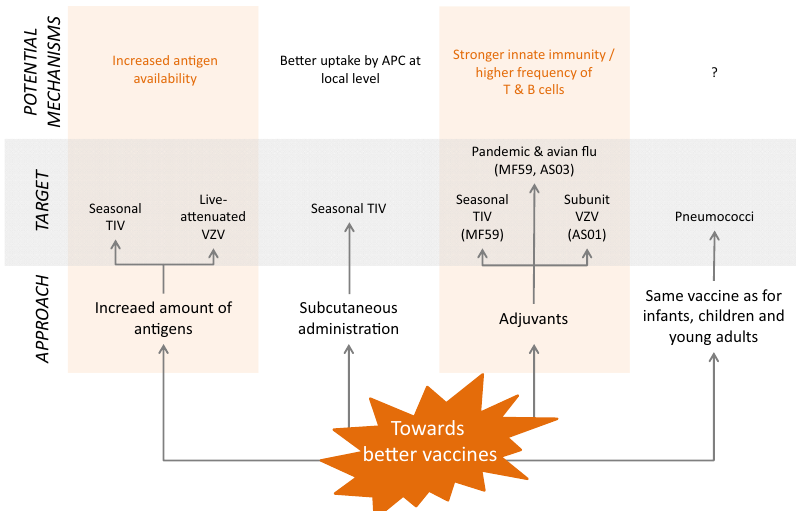
Fig. 3 New approaches towards better vaccines for older adults. APC antigen-presenting cell, AS adjuvant system, TIV trivalent in fl uenza vaccine, VZV varicella zoster